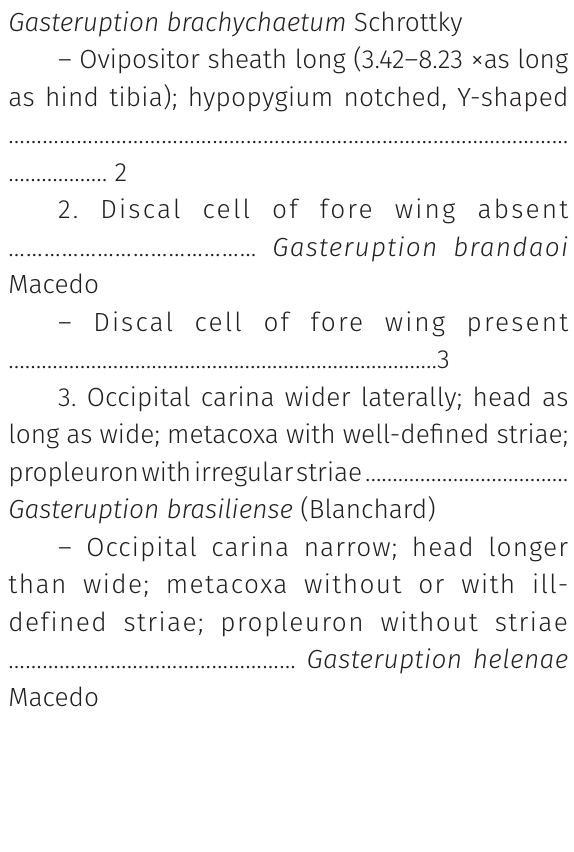
Gasteruption brachychaetum Schrottky, 1906: 61– 62 (description); Kieffer, 1912: 238 (in key), 308– 309 (redescription); Hedicke, 1939: 34 (catalog); Macedo, 2009: 7 ( brachycaetum misprint, cladistic analysis); Rasmussen et al. 2009: 23 (catalog); Macedo, 2011: 18 (redescription); Macedo et al., 2012 (behavior, host record).